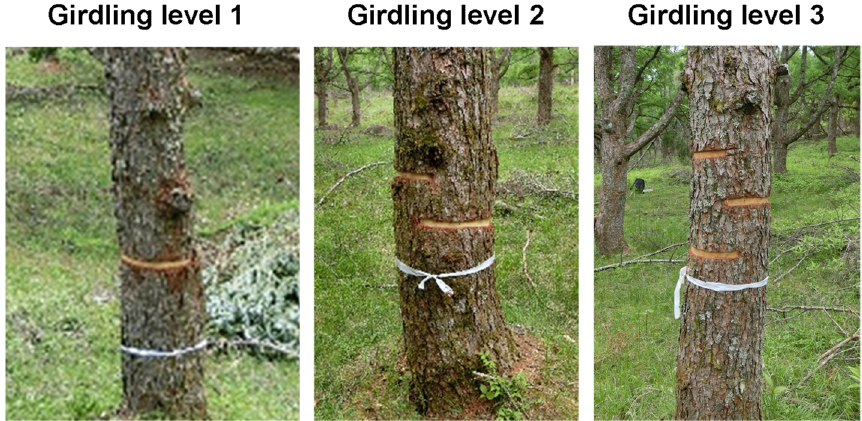
Figure A1. Example photos for girdling levels 1–3.